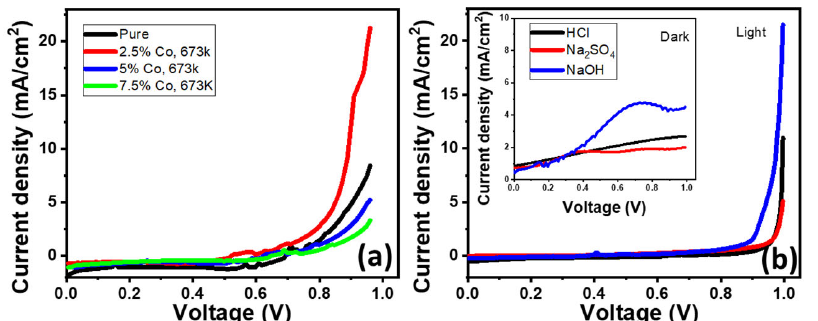
Figure 5. ( a ) The electrodes’ photocurrent density ‐ voltage curves in 100 mL of 0.5 M NaOH for different samples, and ( b ) The (2.5 % Co, 673 K) electrode photocurrent density ‐ voltage curves in 100 mL of 0.5 M HCl, Na 2 SO 4, and NaOH for optimised sample in the existence and absence of light.